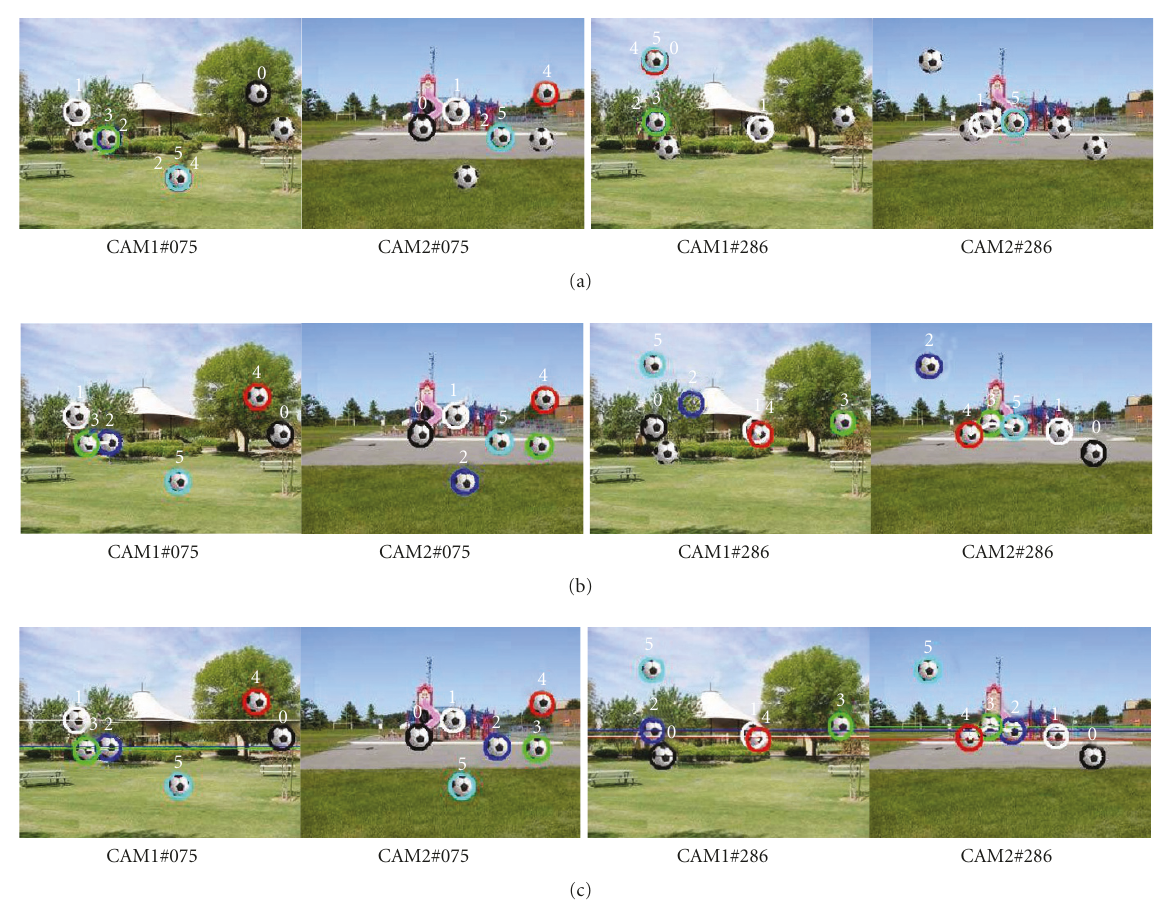
Figure 7: Tracking results of the synthetic videos: (a) multiple independent particle filters [37]; (b) interactively distributed multiple-object tracking [14]; (c) the proposed